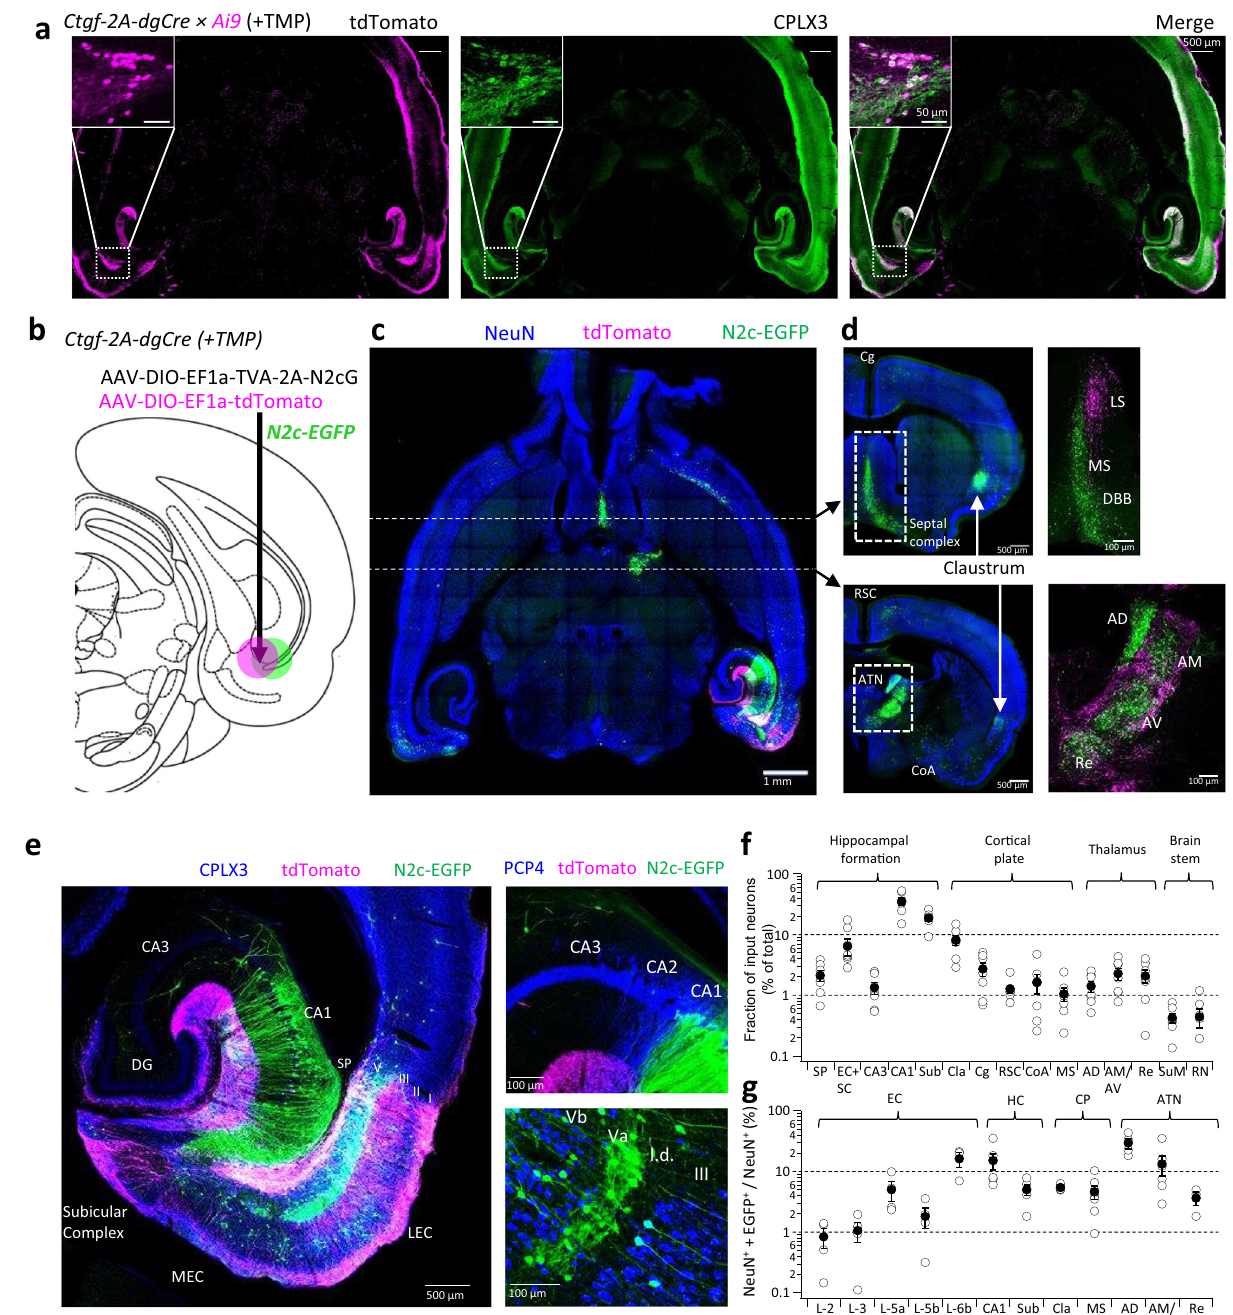
Fig. 3 | Brain-wide connectivity of EC-6b neurons. a Representative horizontal sections from Ctgf-2A-dgCre mouse crossed to the Ai9 tdTomato reporter line demonstrate ef fi cient TMP-inducible genetic dissection of Cplx3 + neurons in the corticallayer6b. b AnillustrationoftheAAVinjectionschemeforsubplate-speci fi c dual anterograde and retrograde labeling. c , d A representative horizontal section followingretrogradelabelingfromtheentorhinalsubplateandimmunolabelingfor NeuN( c )andrepresentativecoronalsections( d ),demonstratingtheprojectionsto, and from, cortical and sub-cortical regions. e A representative horizontal section,